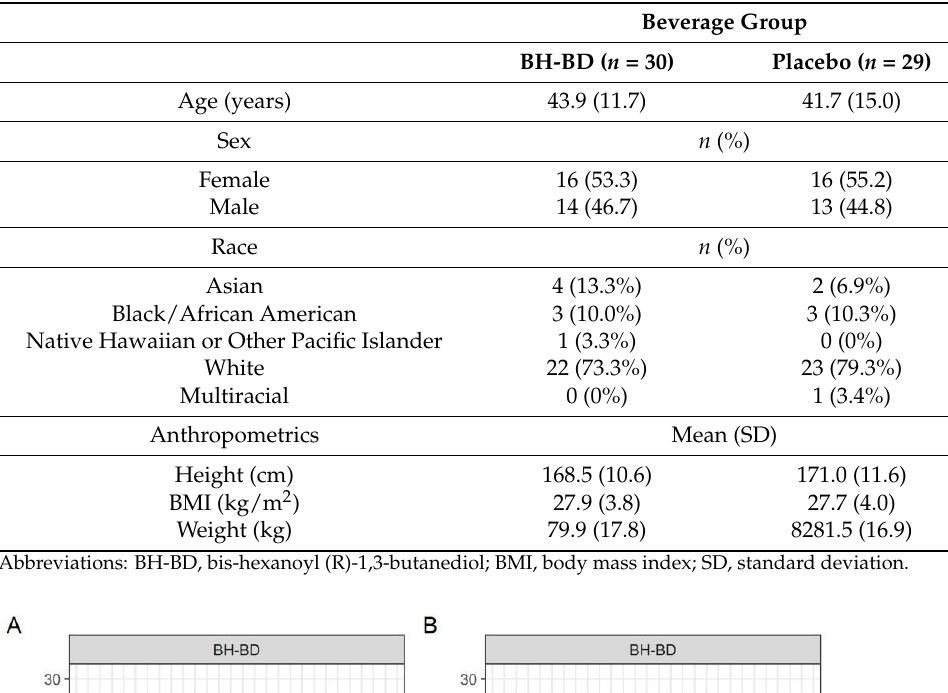
Table 2. Baseline demographic characteristics of randomized participants in the BH-BD and placebo condition.